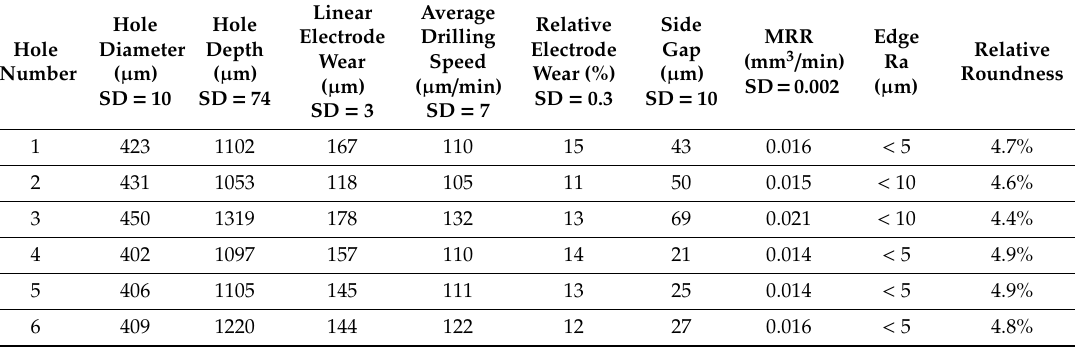
Table 5. Mean and corrected standard deviations (SD) of the measured and calculated values (Bessel’s